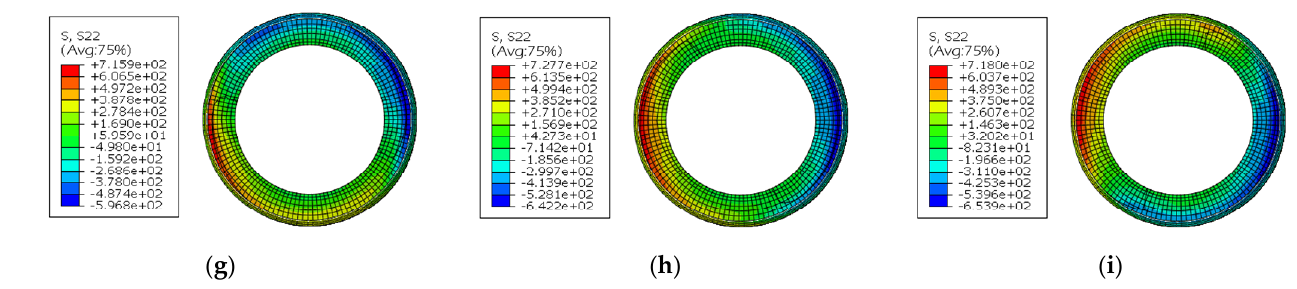
Figure 9. Contour image of axial stress of tubing V-groove section under eccentric wheel loading: ( a ) Eccentric angle = 0°; ( b ) Eccentric angle = 45°; ( c ) Eccentric angle = 90°; ( d ) Eccentric angle = 135°; ( e ) Eccentric angle = 180°; ( f ) Eccentric angle = 225°; ( g ) Eccentric angle = 270°; ( h ) Eccentric angle = 315°; ( i ) Eccentric angle = 360°.